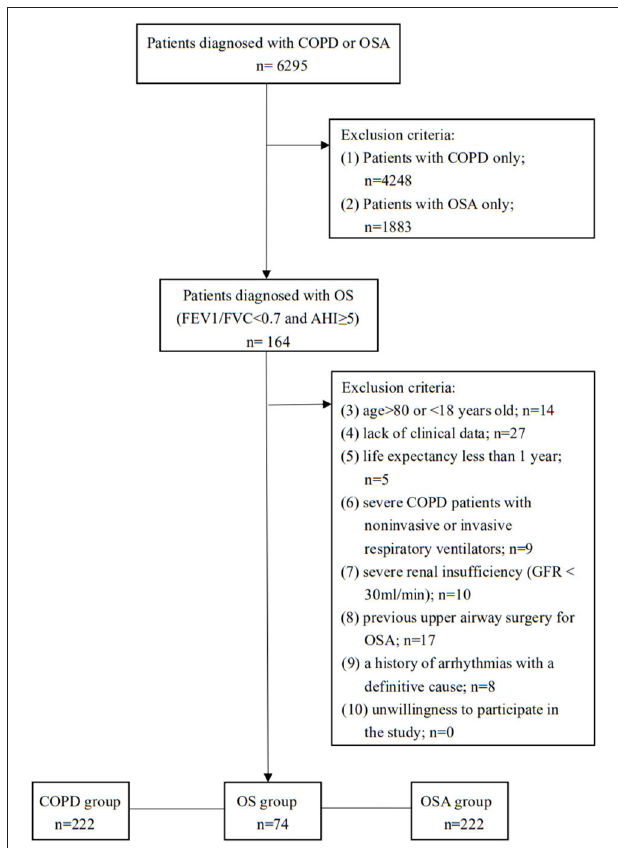
FIGURE 1 | Study protocol. OS, overlap syndrome; OSA, obstructive sleep apnea; COPD, chronic obstructive pulmonary disease; AHI, apnea-hypopnea index; FEV1/FVC, forced expiratory volume in 1 s/forced vital